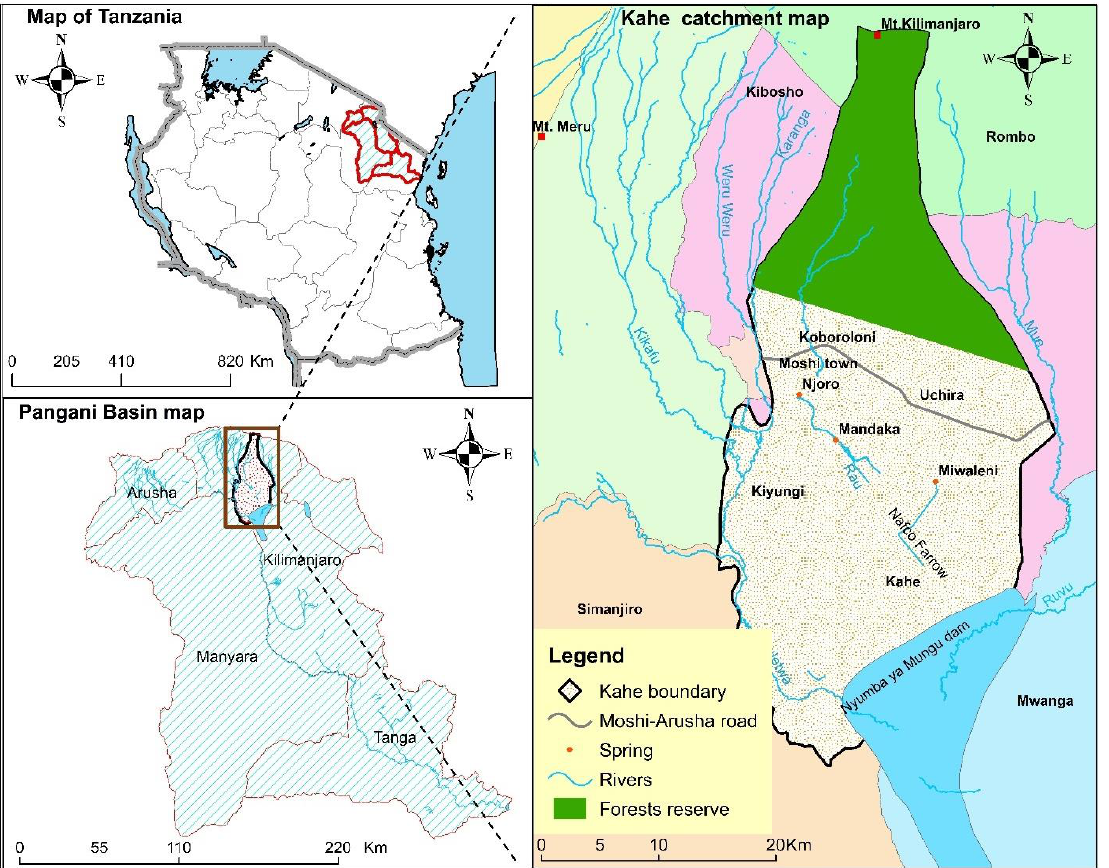
Figure 1. Study area map of Kahe catchment.